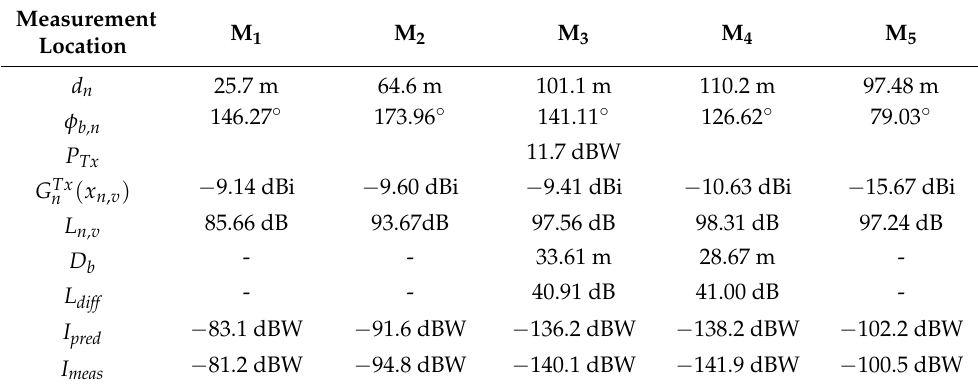
Table 3. Comparison between Measured and Predicted Interference Levels.